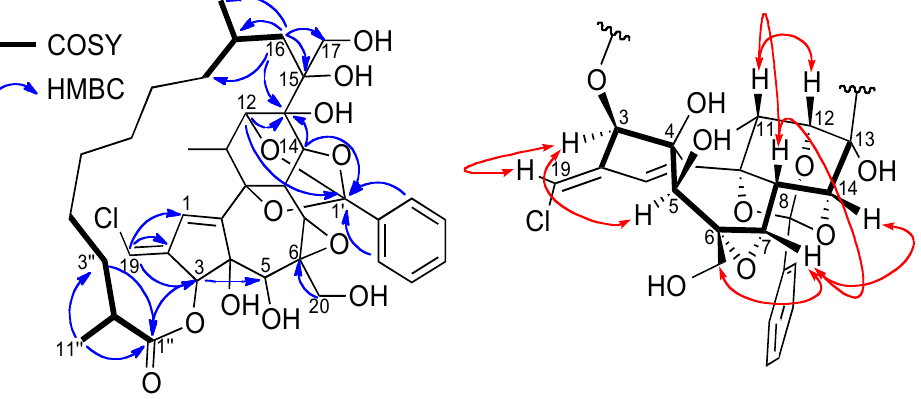
Figure 4. Key COSY and HMBC (left), and ROESY (right) correlations of compound 2